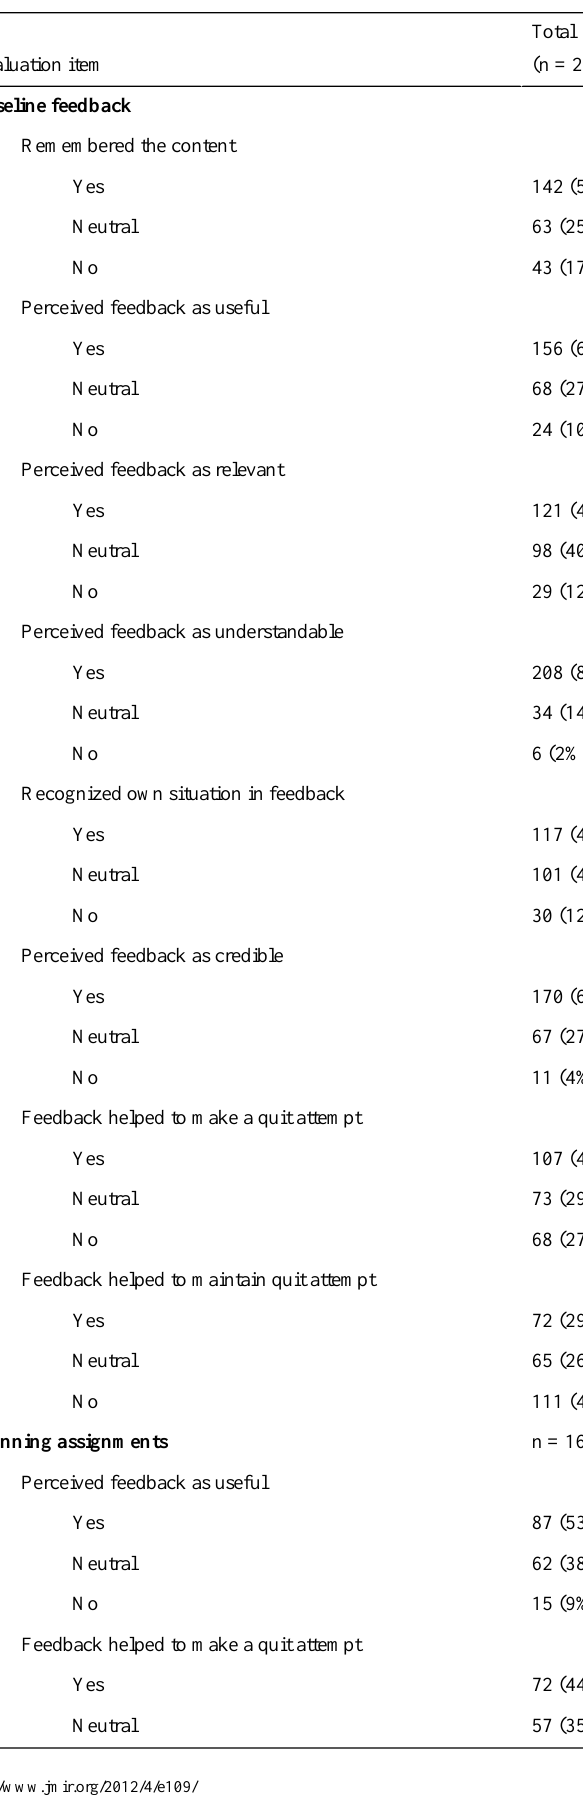
Table 5. Program evaluation (conducted 6 months after baseline) by respondents from the AP a and the AP+ b